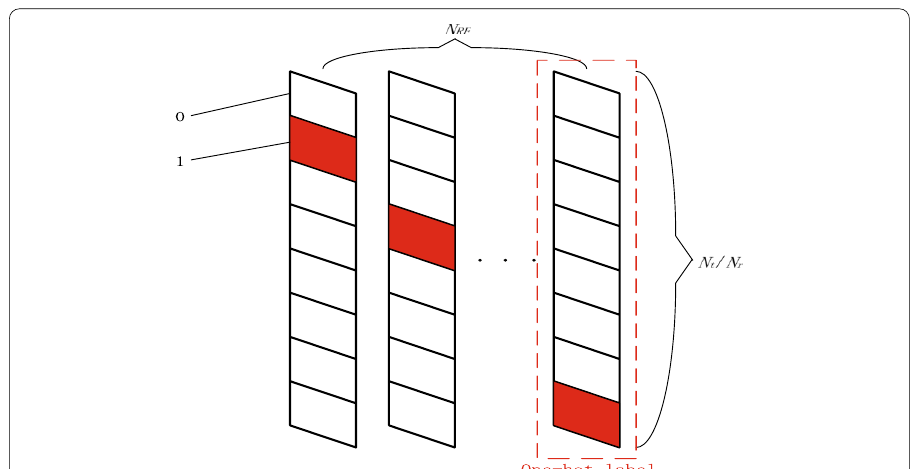
Fig. 9 Selector in transmitter/receiver as N RF one-hot